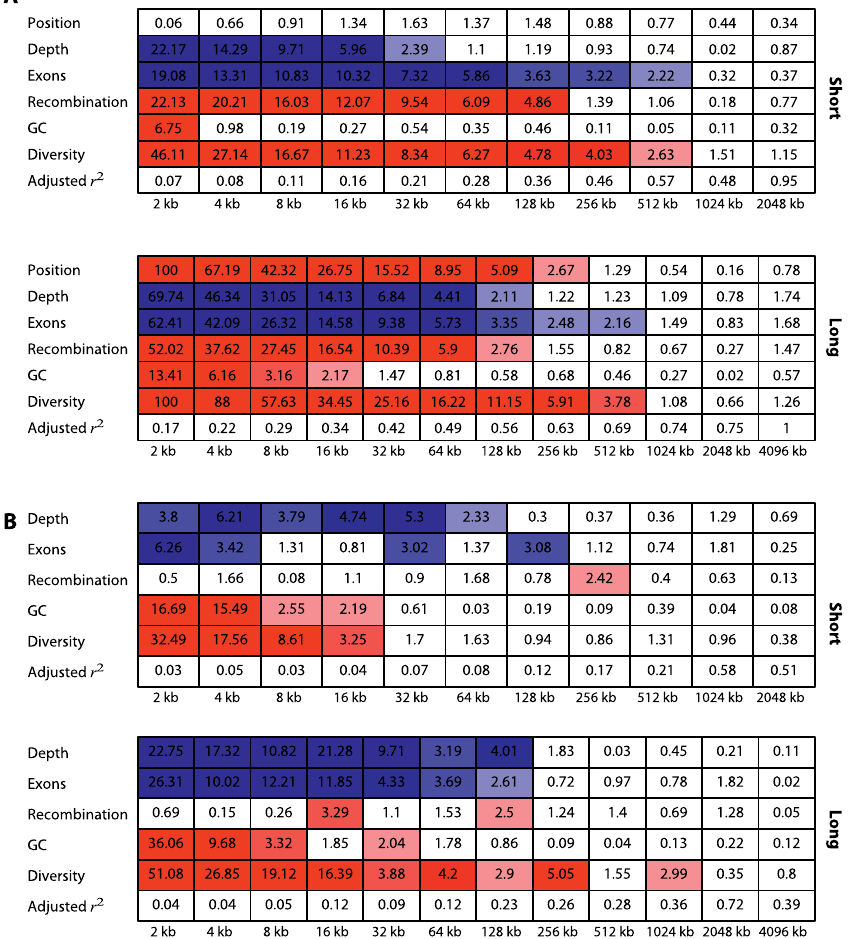
Figure 4. Marginal Significance ( (cid:1) log 10 p-value as Determined by t- Test) of the Wavelet Coefficients from Four Annotations as Predictors of the Coefficients of the Decomposition of Human-Chimpanzee Divergence Red boxes highlight significant positive linear relationships, and blue boxes, negative. The intensity of the colour is proportional to the degree of significance. (A) Smoothed coefficients. (B) Detail